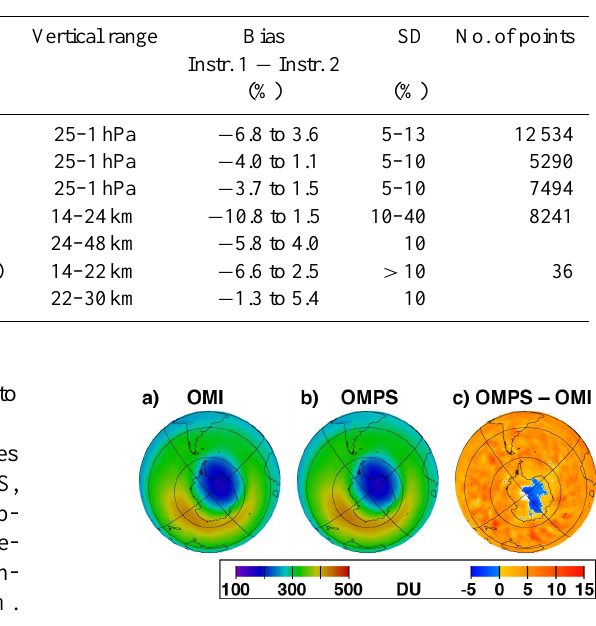
Fig. 3. Total column ozone from (a) OMI, (b) OMPS TC-NM, and (c) their difference (OMPS TC-NM − OMI) for October